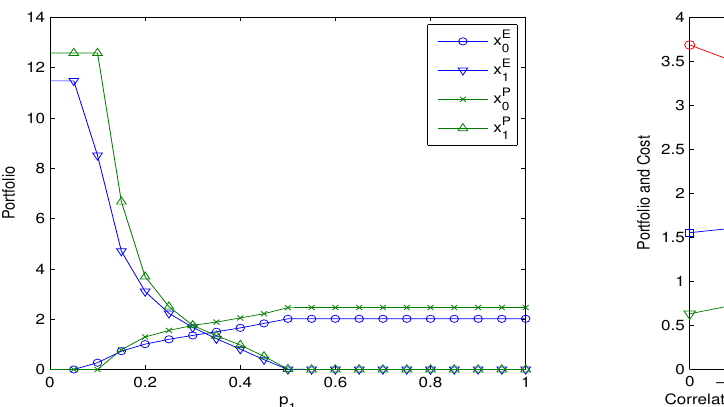
Figure 5. Optimal spectrum portfolio composition for different choices of the unit price of secondary contract.